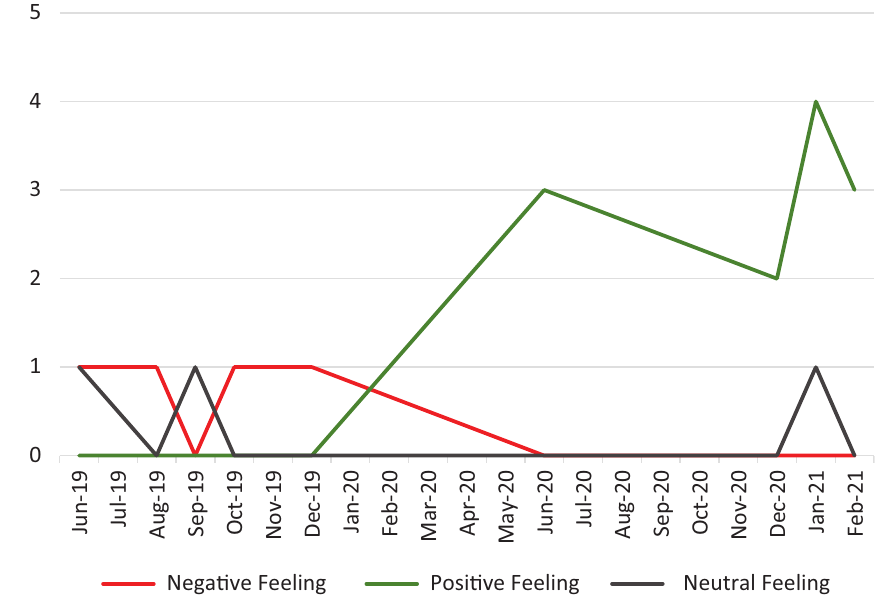
Figure 7. Digital media negative, positive, and neutral positions timeline (June 2019–February 2021). traffic management (13%). Other issues related to bud‐ get and finance (8.7%), pedestrian accessibility